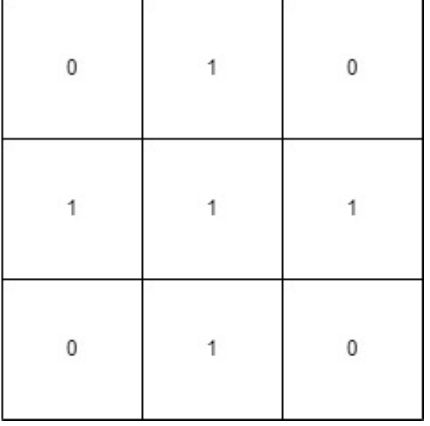
Figure 6. Visualization of 3 × 3 cross shape structuring element.